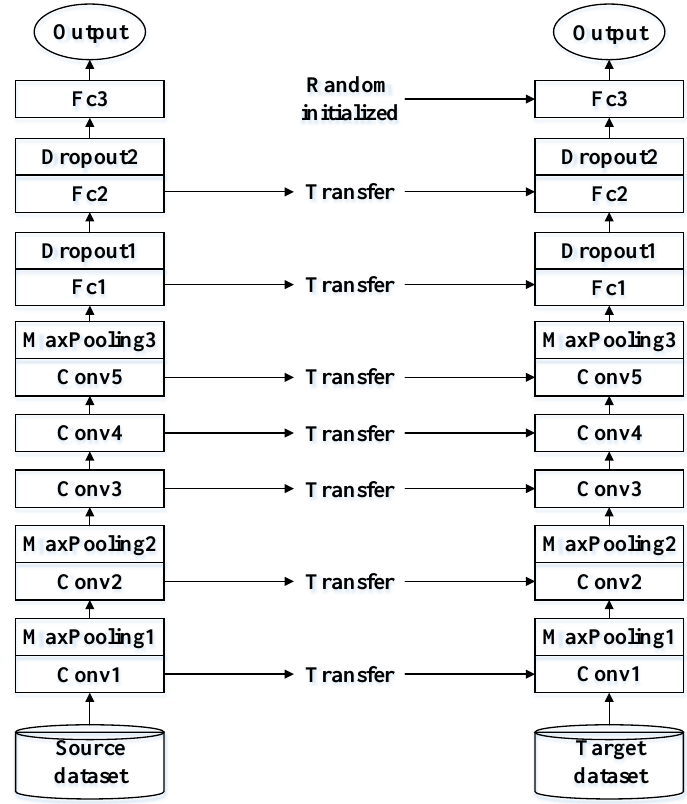
Figure 1. Details of the traditional transfer learning method.